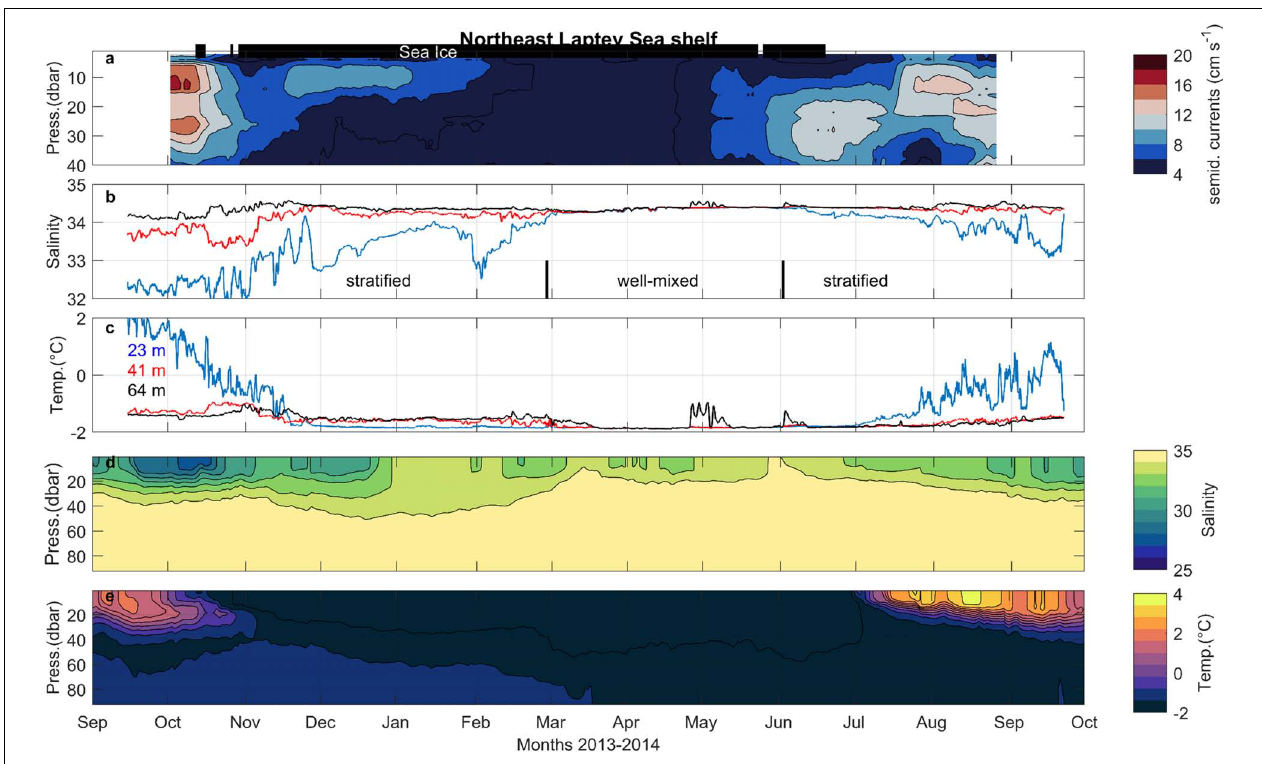
FIGURE 10 | Same as Figure 8 but for the Northeast –